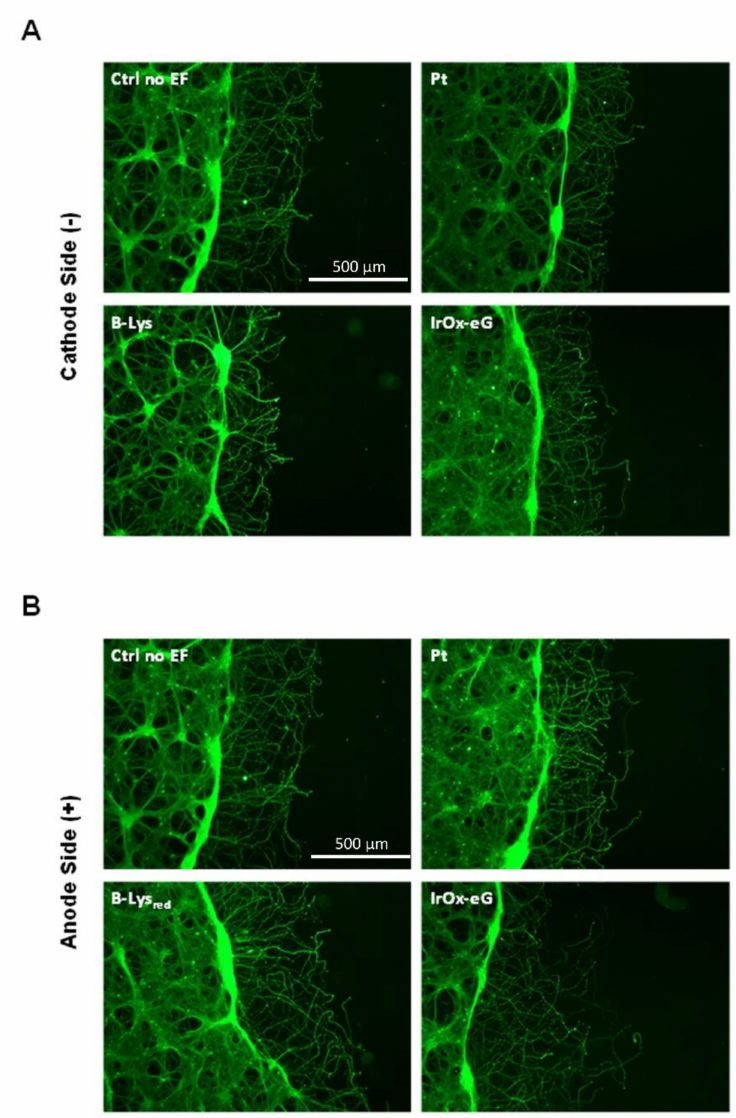
Figure 14. Scratch model repair under the application of an electric field using IrO x -graphene as substrate, ( A ) cin cathode and ( B ) anode areas. The firs image in each set corresponds to the reference spontaneous scratch growth using polypyrrole surface on PEDOT with lysine counterions. (Note that cells are near polypyrrole and not PEDOT in the polymer bilayer). Scale bars are equal for all images. [22] B-lys is a PEDOT-Polypyrrole bilayer with lysine counterion, IrO x -eG is the hybrid described in this work. With permission from